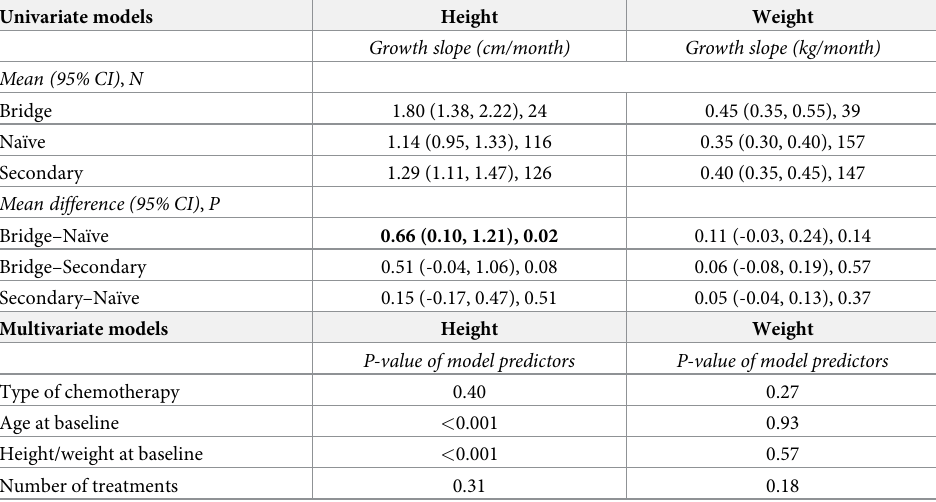
Table 2. Height and weight growth by group and group